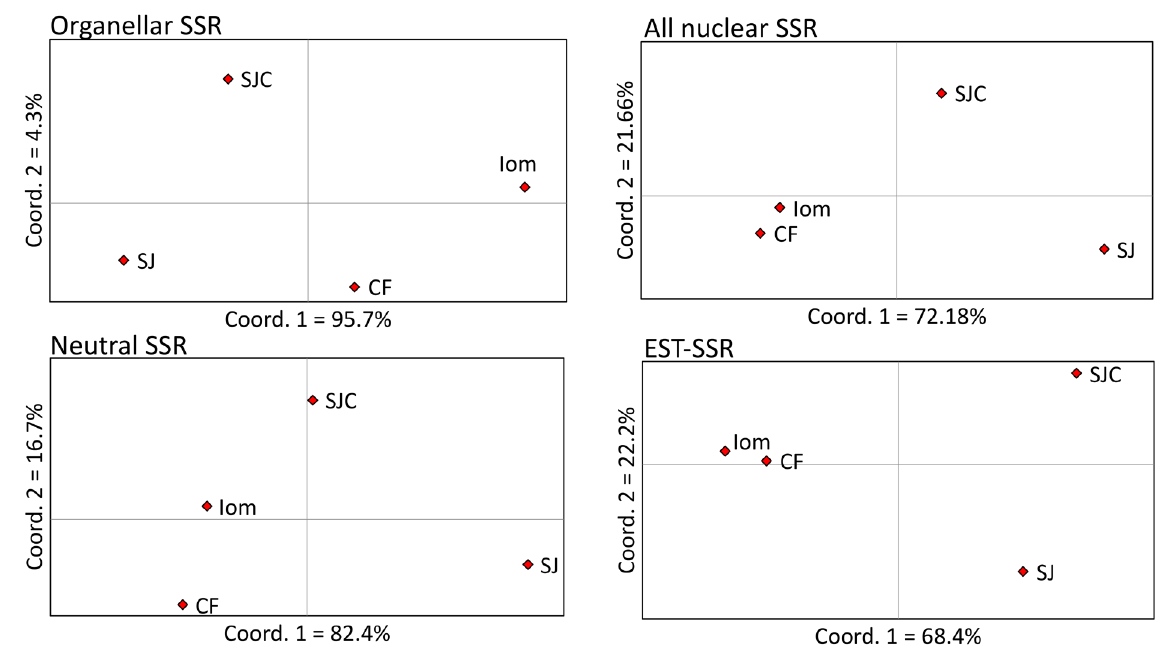
Figure 4. Ordination analysis (PCoA) of the C. xanthocarpa studied forest fragments based on organellar microsatellites, all nuclear markers together, neutral markers and gene-linked markers